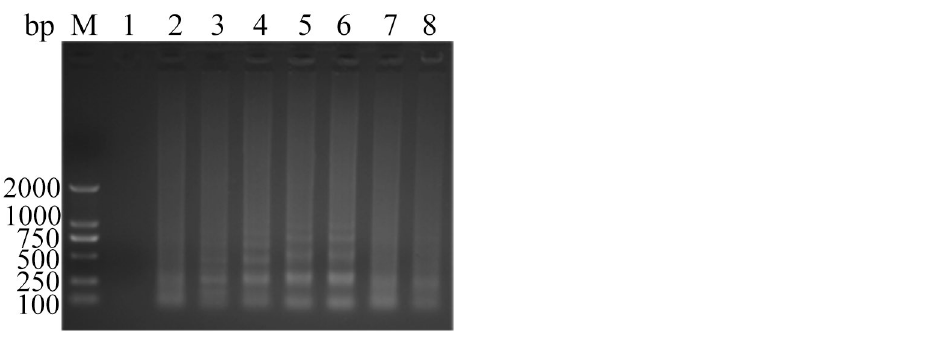
Figure 6. Analysis of ALV-J CPA at different units of Bst DNA polymerase (8 units μL −1 ) by agarose gel electrophoresis. Lane M, DNA markers; 1, 0 units μL −1 ; 2, 0.064 units μL −1 ; 3, 0.128 units μL −1 ; 4, 0.192 units μL −1 ; 5, 0.256 units μL −1 ; 6, 0.32 units μL −1 ; 7, 0.48 units μL −1 ; 8, 0.64 units μL −1 . The full-length gel is presented in Supplementary Figure S22.